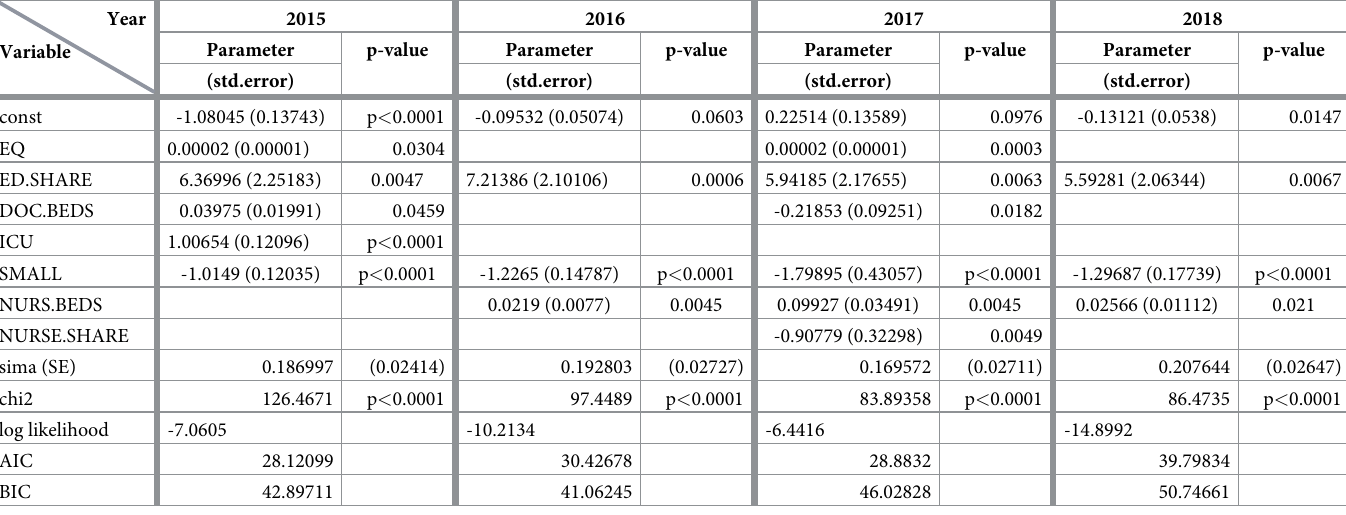
Table 14. Results of Tobit regression of inefficiency on hospital characteristics ( general